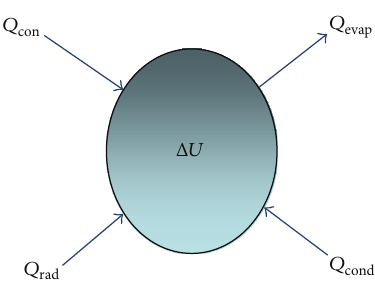
Figure 2: Water droplet energy